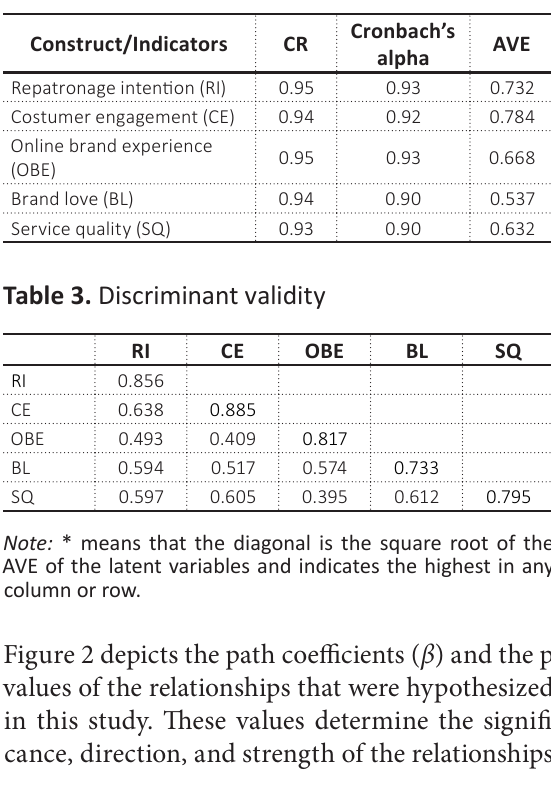
Table 2. Composite reliability, Cronbach’s alpha,